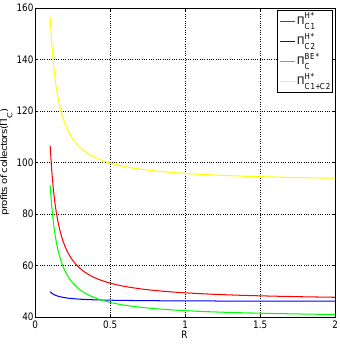
Figure 19. The influences of R on the collector’s profit Π C